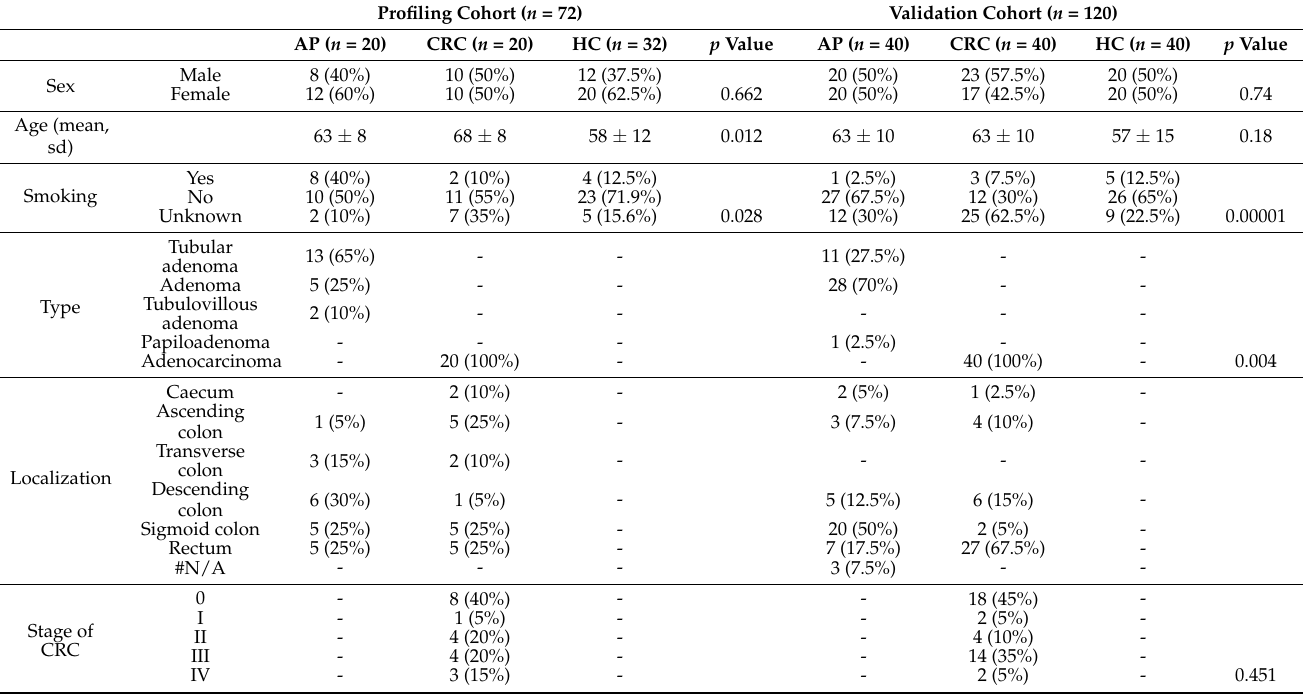
Table 1. Clinical and phenotypic information of profiling and validation cohorts. Categorical vari- ables are summarized as absolute numbers and percentages (in parentheses), while age (quantitative variable) is summarized as mean and standard deviation. To test for differences among groups, Chi squared test was used for categorical variables, while Kruskal-Wallis test was used for quantita- tive